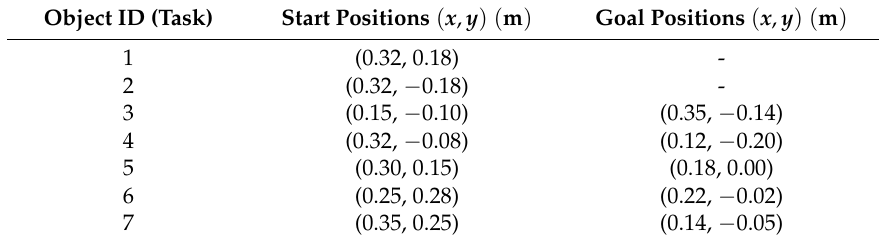
Table 5. Simulation conditions in Experiment 2.